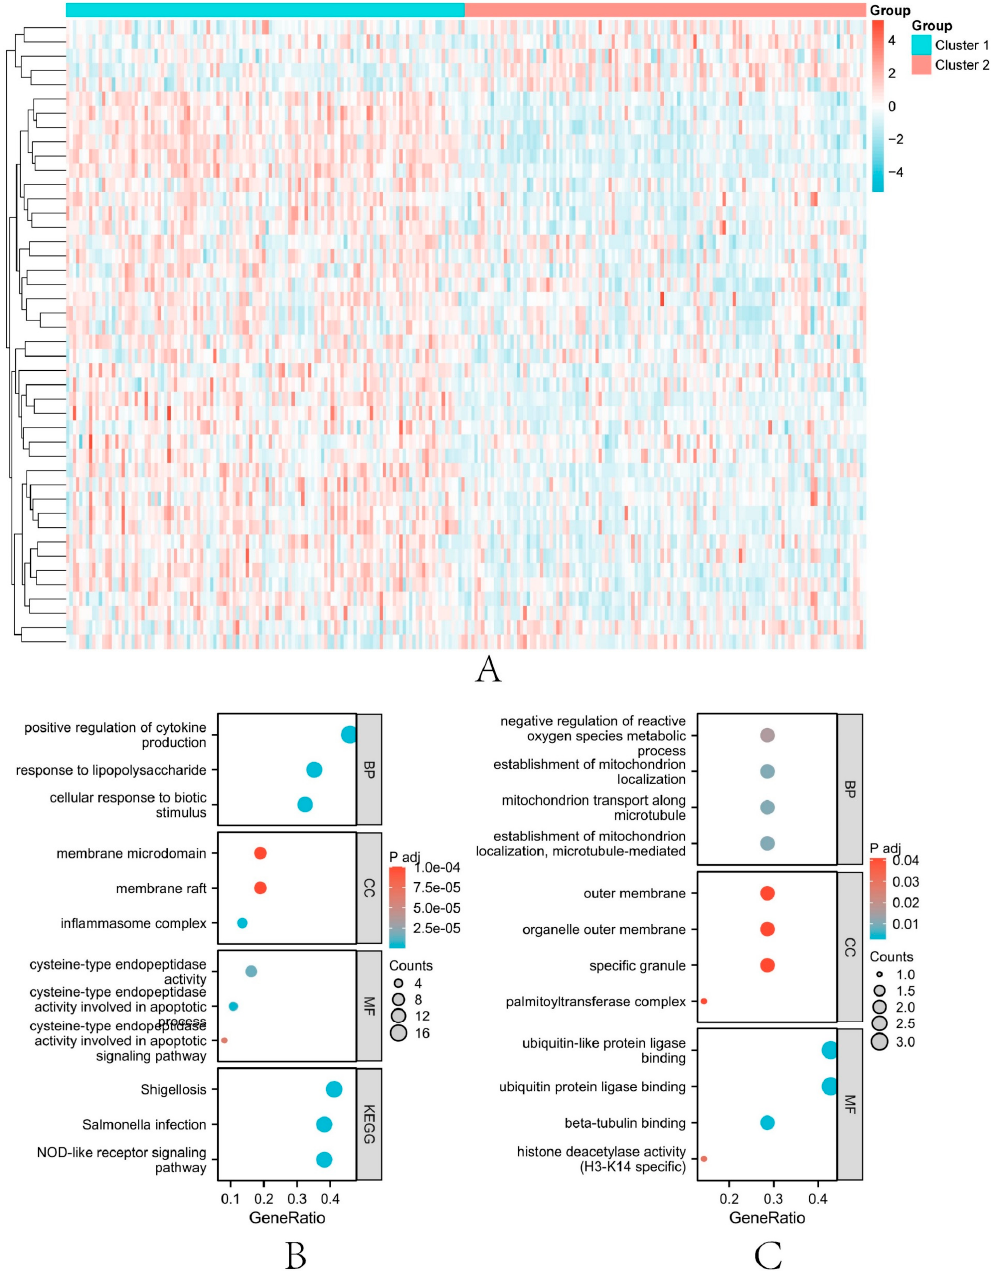
Figure 4. Results of differential and enrichment analysis of genes in the two subtype groups. ( A ) 44 differentially expressed genes ( 𝑝 < 0.05) in the two subtype groups. ( B ) the bubble plot of the GO pathway and KEGG pathway in which up-regulated genes are involved. ( C ) the bubble plot of the GO pathway and KEGG pathway in which down-regulated genes are